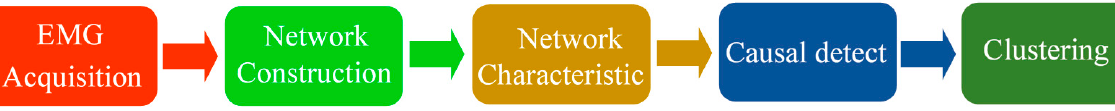
Figure 1. Flowchart of all stages.